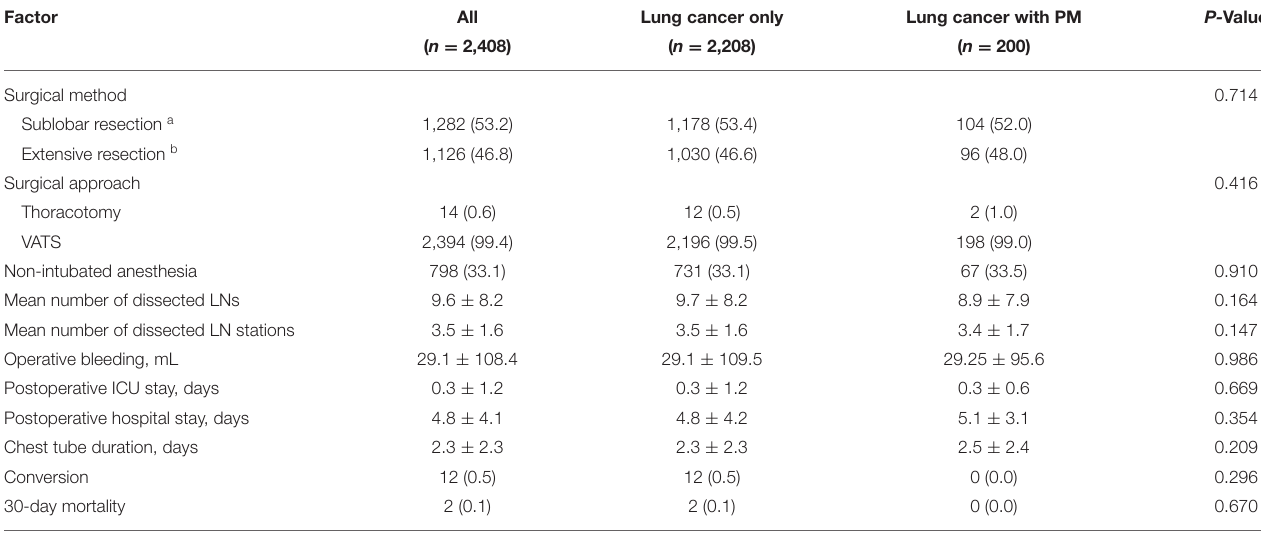
TABLE 3 | Perioperative outcomes. Factor All Lung cancer only Lung cancer with PM